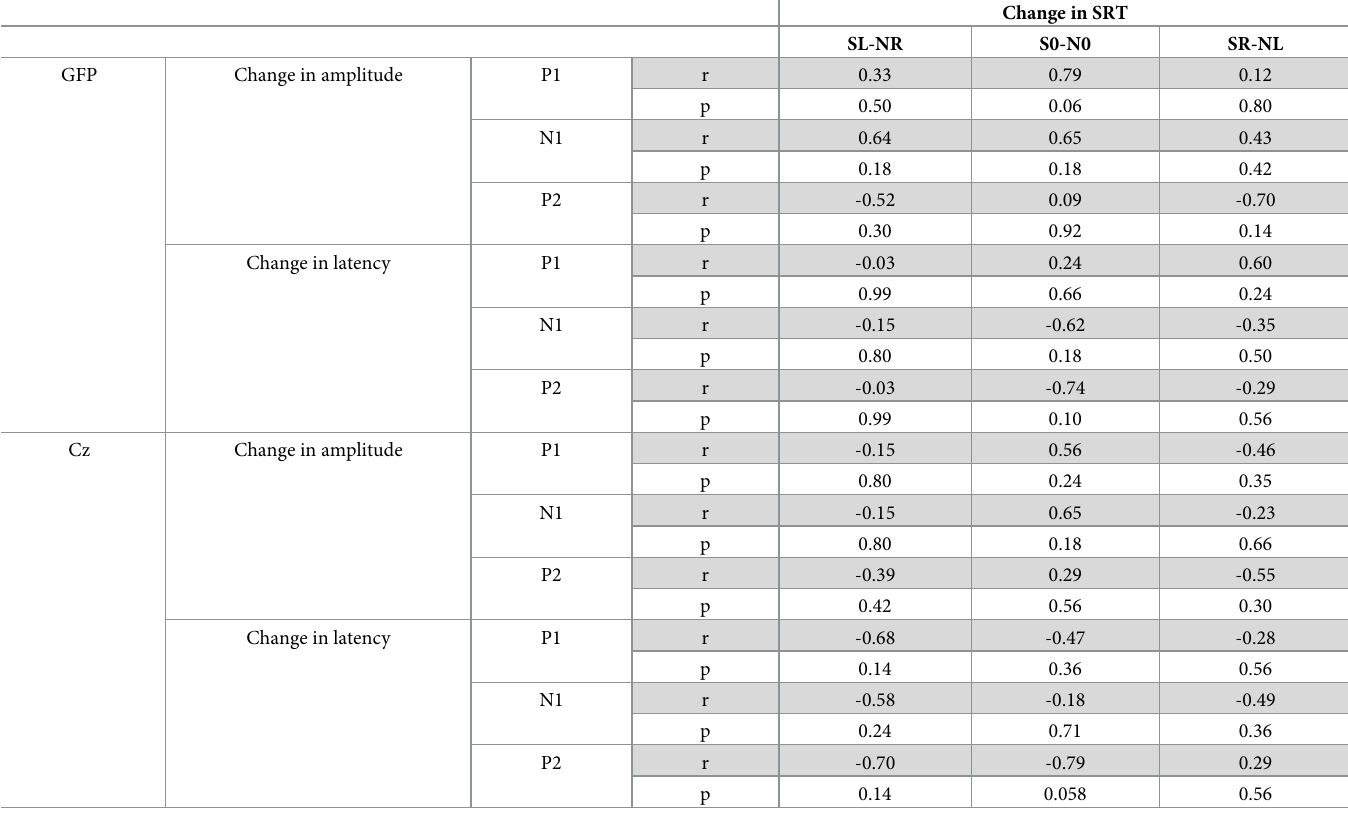
Table 5. Results of Spearman correlations comparing the change in SRTs (from baseline to 12m) for the different spatial conditions and changes in GFP and CAEP amplitudes and latencies in noise (from baseline to 12m) in SSD-CI